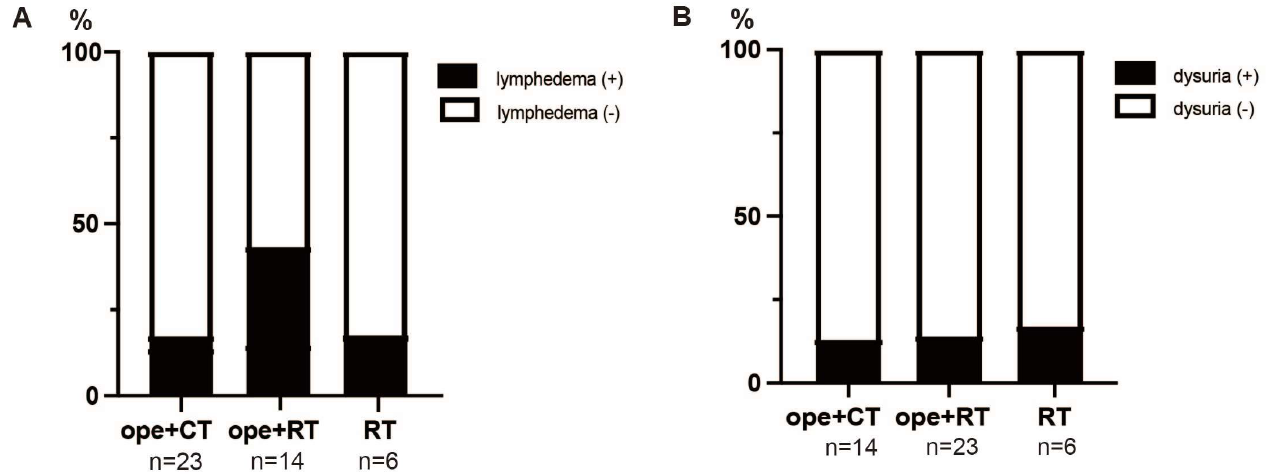
Figure 4. Post–treatment complications in patients with (tumor and node) T1/T2N1. ( A ) Number of leg lymphedema occurrences. ( B ) Number of dysuria occurrences. ope+CT, patients who underwent surgery and chemotherapy (neoadjuvant or adjuvant); ope+RT, patients who underwent surgery followed by radiotherapy (including concurrent chemoradiotherapy); and RT, patients who underwent radiotherapy (including concurrent chemoradiotherapy). Complication frequency was performed the Fisher’s exact test.